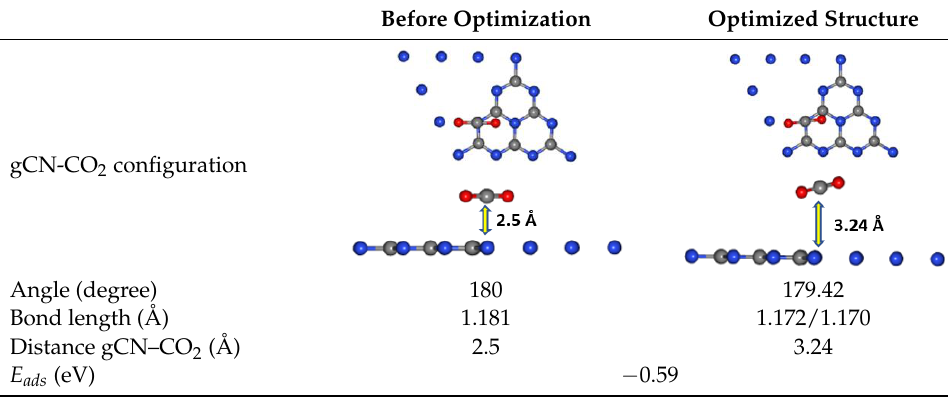
gCN-CO 2 configuration